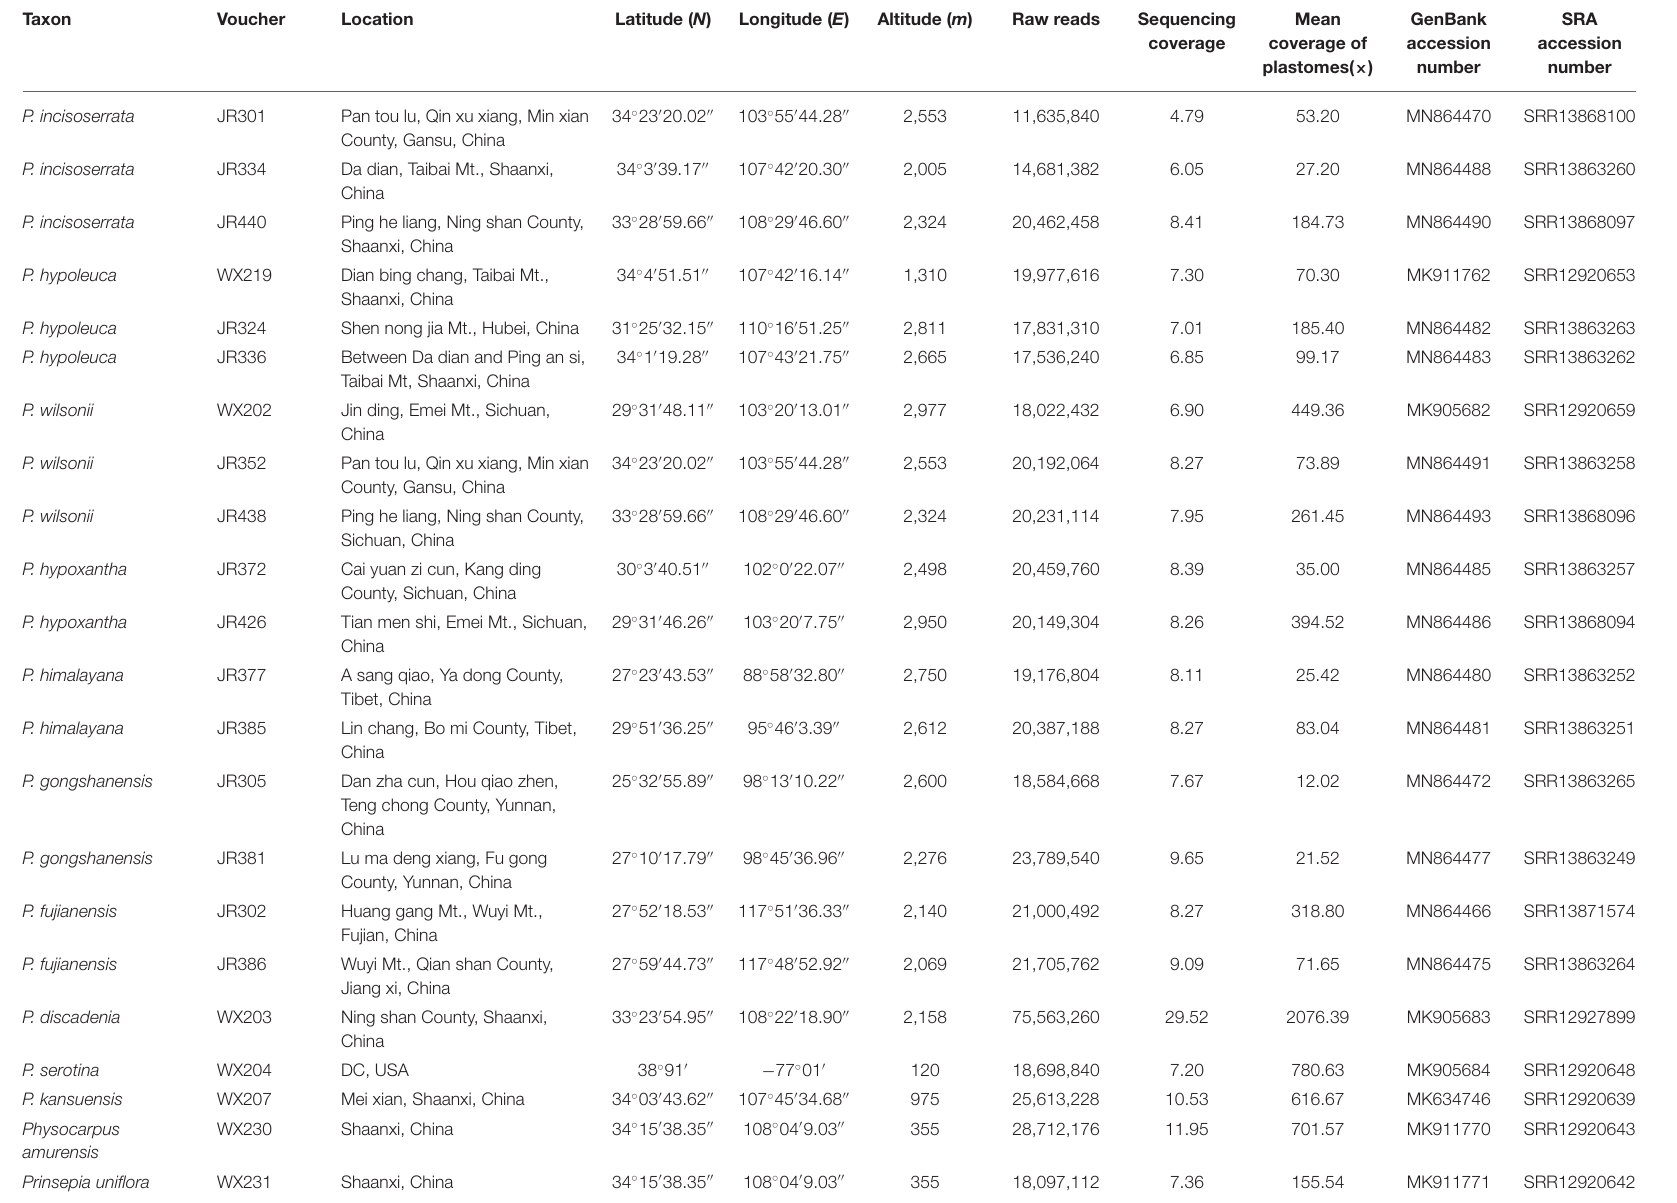
TABLE 1 | Voucher information and GenBank accession numbers of sampled